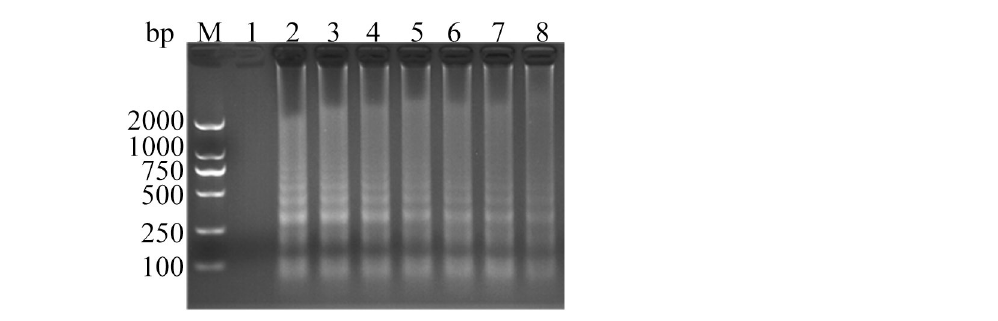
Figure 4. Analysis of ALV-J CPA at different concentration of Betaine by agarose gel electrophoresis. Lane M, DNA marker; 1, 0 mol L −1 ; 2, 0.2 mol L −1 ; 3, 0.4 mol L −1 ; 4, 0.6 mol L −1 ; 5, 0.8 mol L −1 ; 6, 1.0 mol L −1 ; 7, 1.2 mol L −1 ; 8, 1.4 mol L −1 . The full-length gel is presented in Supplementary Figure